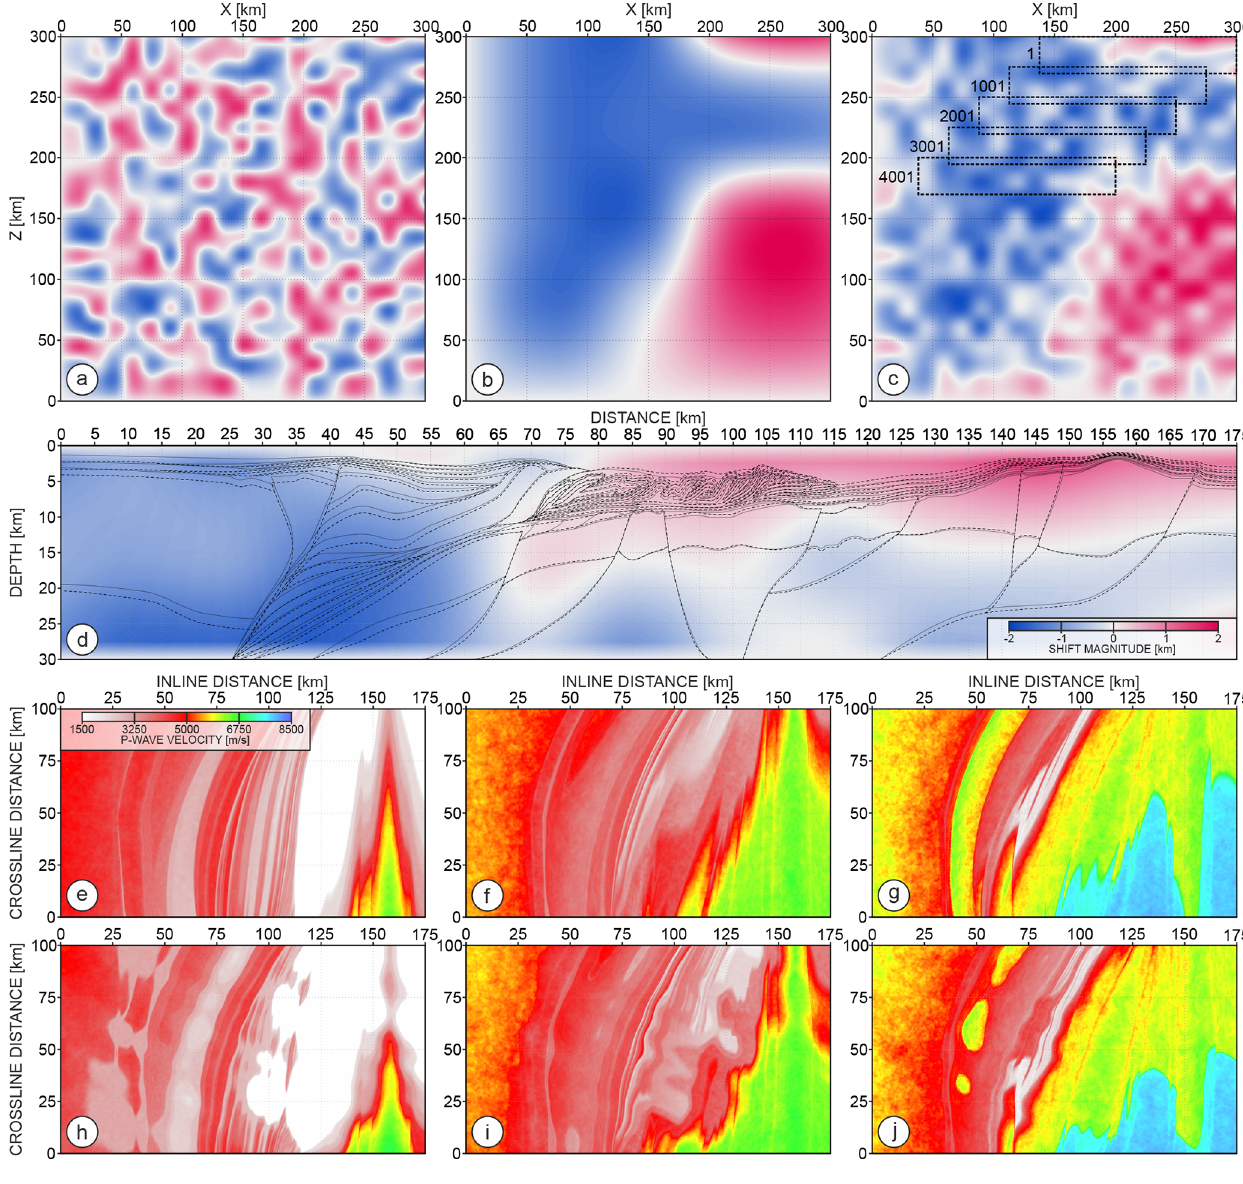
Figure 8. (a, b) Spaces of random small- and large-scale spatial shifts respectively; (c) final space of shifts – average from (a, b) . Dashed rectangles mark extracted matrices of shifts for inlines at each 20km of crossline distance; (d) matrix of shifts extracted from (c) (black dashed rectangle number 1). Grey solid and black dashed lines represent the structure before and after warping respectively; (e, f, g, h, i, j) depth-slice sections extracted at 5, 7.5, and 10km before and after warping